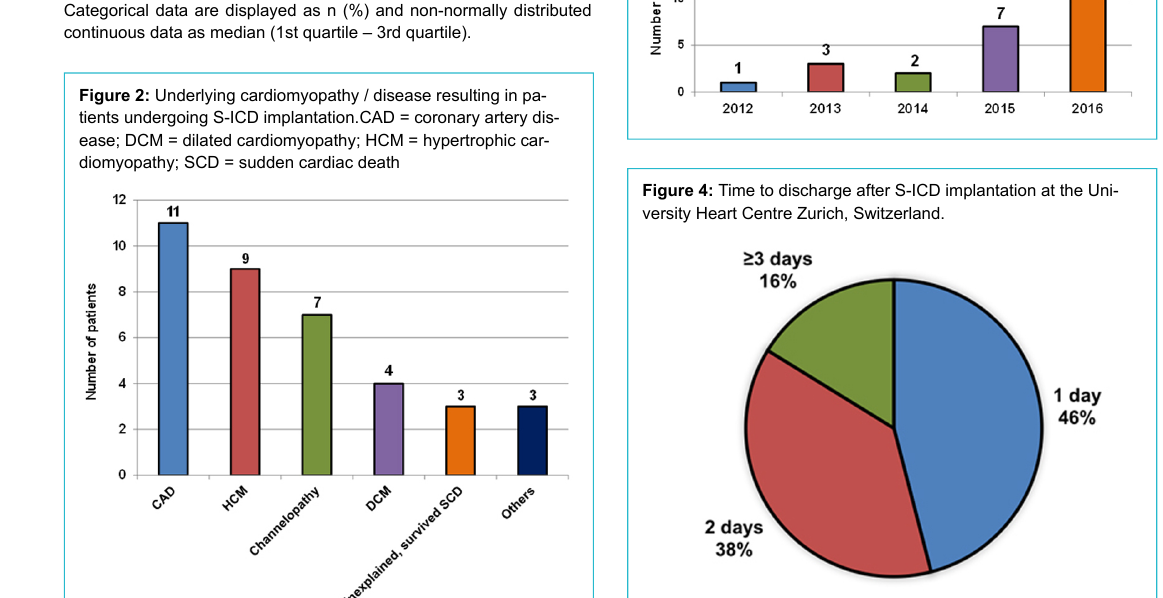
Figure 2: Underlying cardiomyopathy / disease resulting in pa- tients undergoing S-ICD implantation.CAD = coronary artery dis- ease; DCM = dilated cardiomyopathy; HCM = hypertrophic car- diomyopathy; SCD = sudden cardiac death